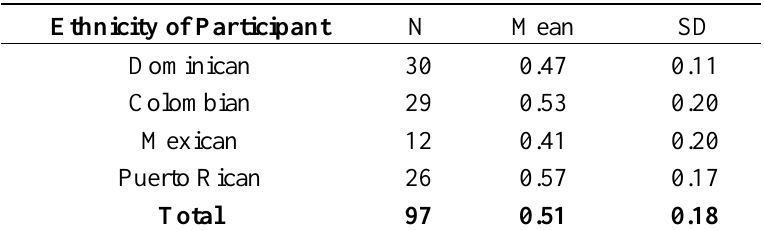
Table 5. Mean Blau diversity index score by